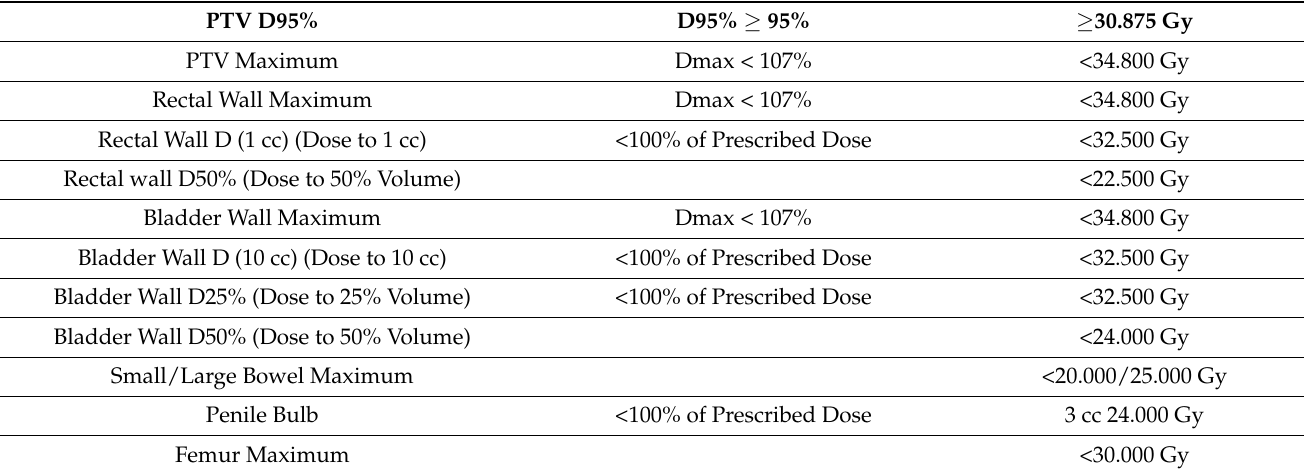
Table 1. Treatment Planning Dose–Volume Constraints for Post-prostatectomy